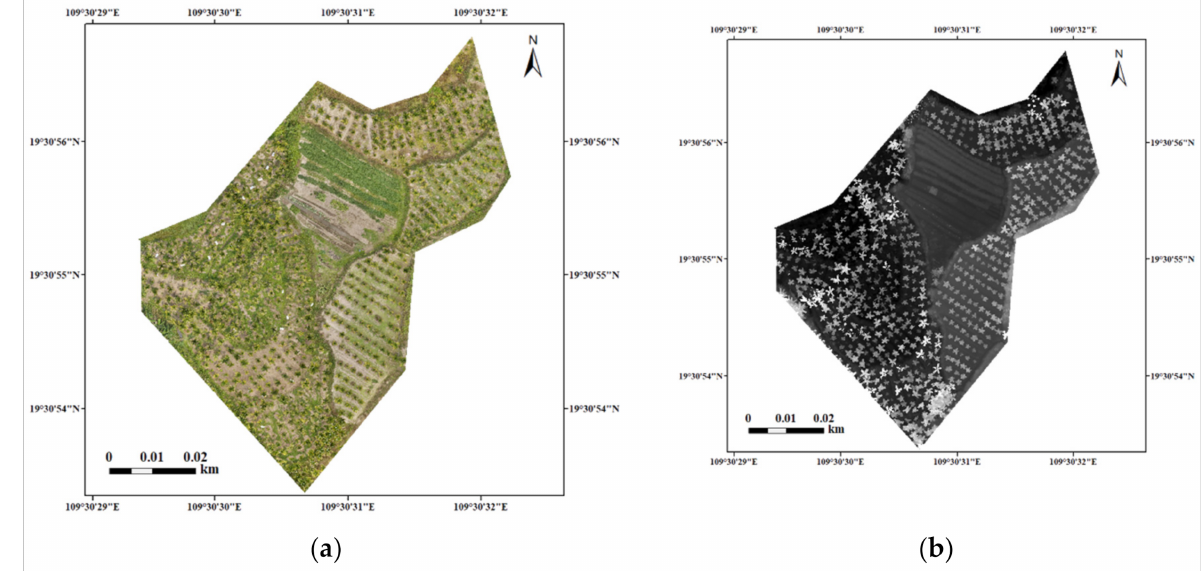
Figure 7. Research area: ( a ) DOM; ( b ) DSM.